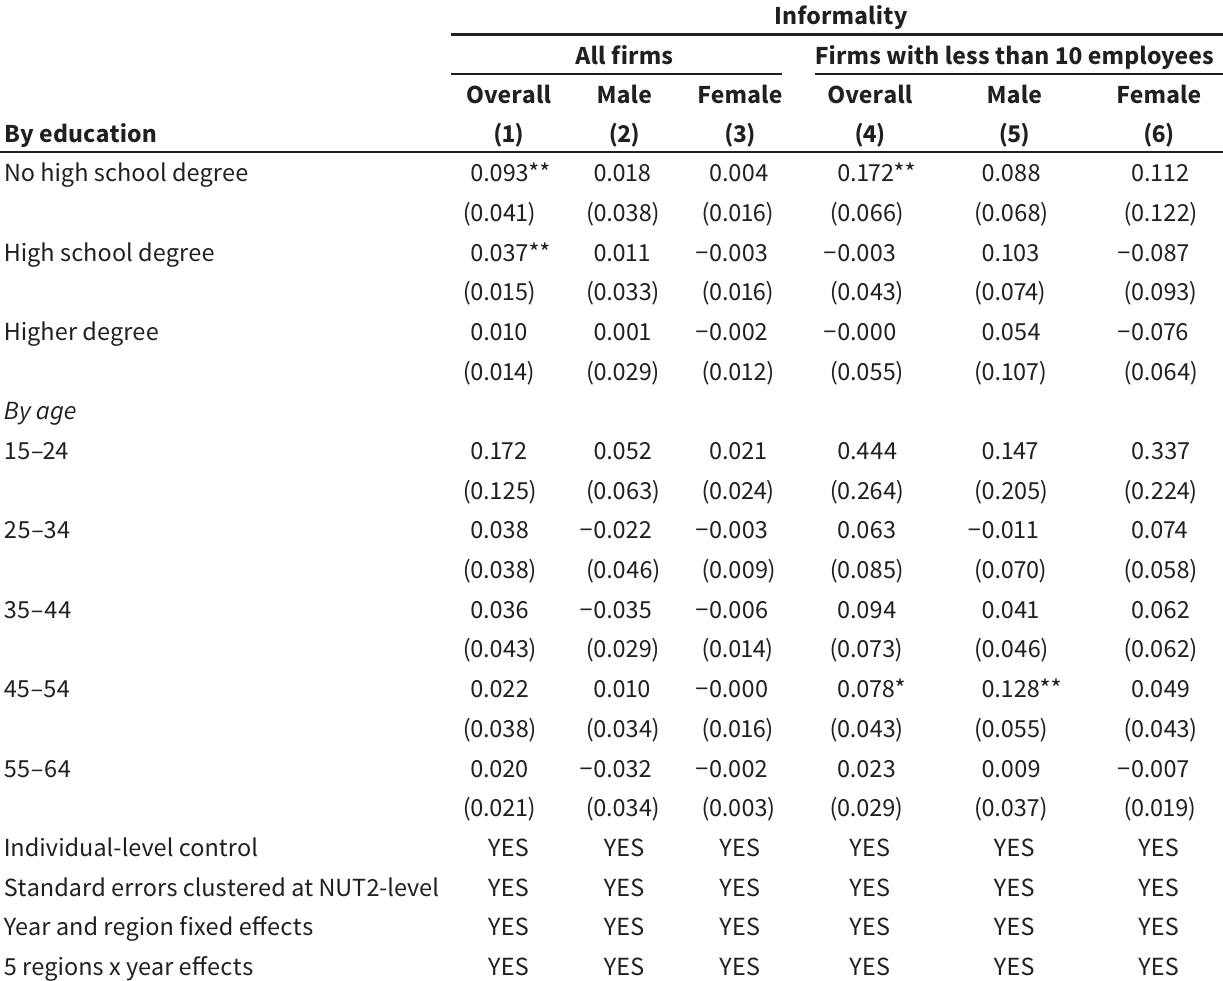
Informality effects, baseline estimation using the baseline fraction affected exposure